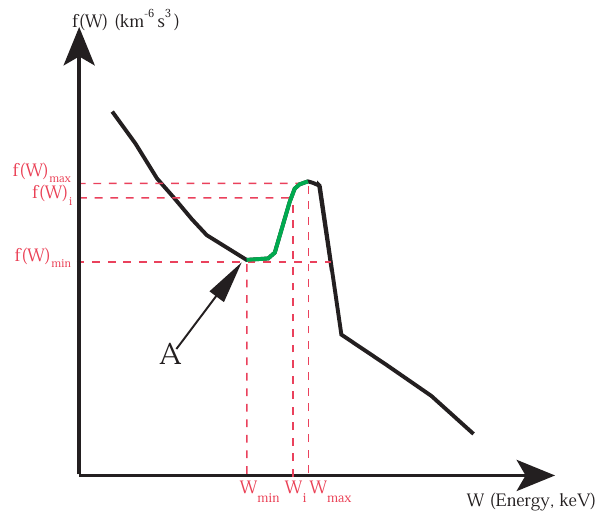
Figure 2. Fig. 2. Schematic indicating how the amount of free energy con- tained in the positive gradient region is calculated. All data points in the positive gradient region (marked in green) are transposed to a location in phase space marked by point A.